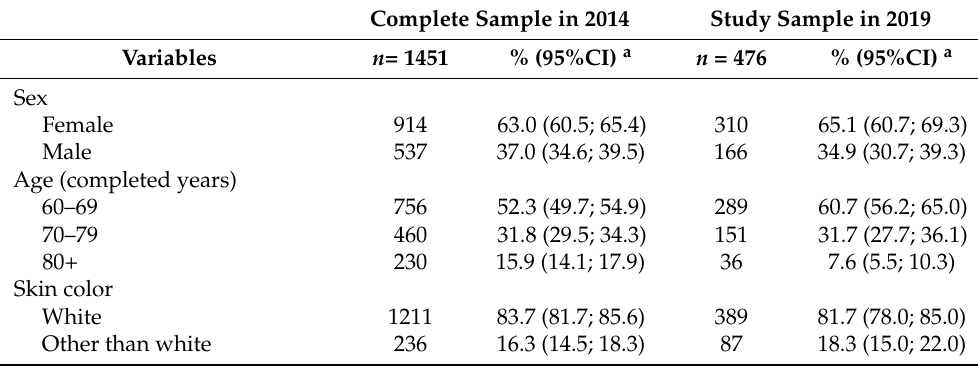
Table 1. Sample description according to sociodemographic, behavioral, and health-related character- istics in the 2014 and 2019 years of the COMO VAI?